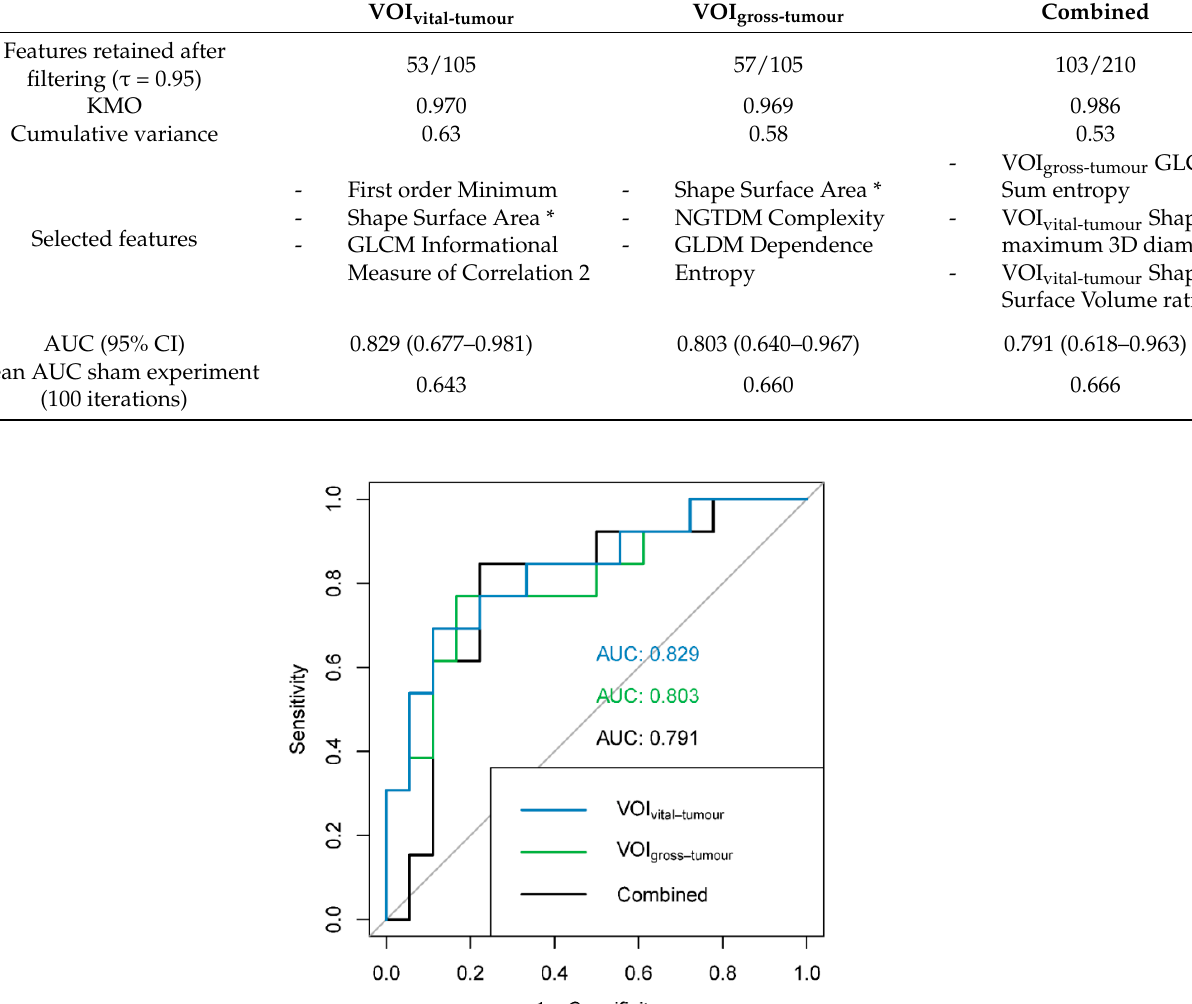
For each of the three radiomic models evaluating predictive performance (VOI vital-tumour , VOI gross-tumour and combined) for the PPGL dataset, three factors were retained and the three best corresponding features were selected (Table 5). The KMOs of the models were excellent (>0.96). AUCs varied 0.791–0.829, but were not significantly different between the radiomic VOI gross-tumour vs. combined: p = 0.874; Figure 3). The mean AUCs of the sham experiments